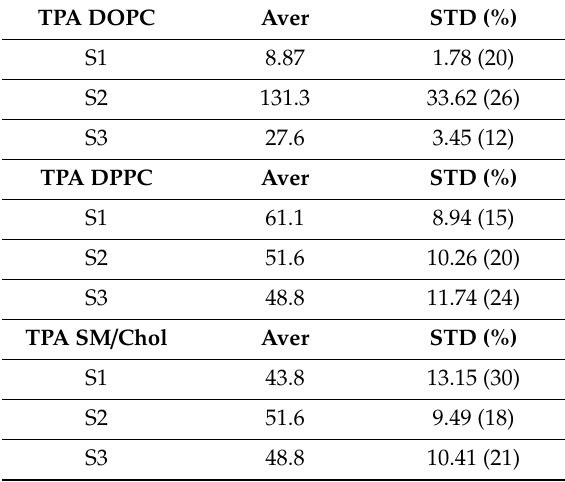
Table A3. Average values and standard deviations (STD) for the simulated TPA (two photon absorption) spectra (in GM units). The relative STD is given in parentheses.